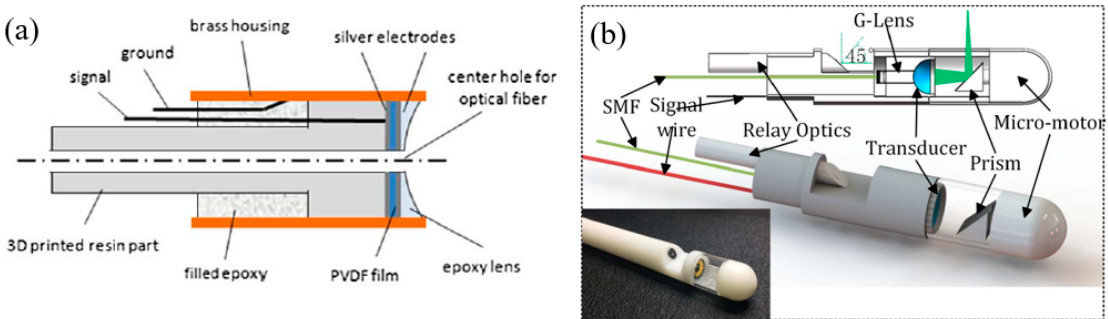
Figure 13. ( a ) Schematic of the lens-focused PVDF pMUT (Reproduced with permission from OSA [61]). ( b ) Schematic of the photoacoustic-hyperspectral imaging endoscope (Reproduced with permission from OSA [62]).